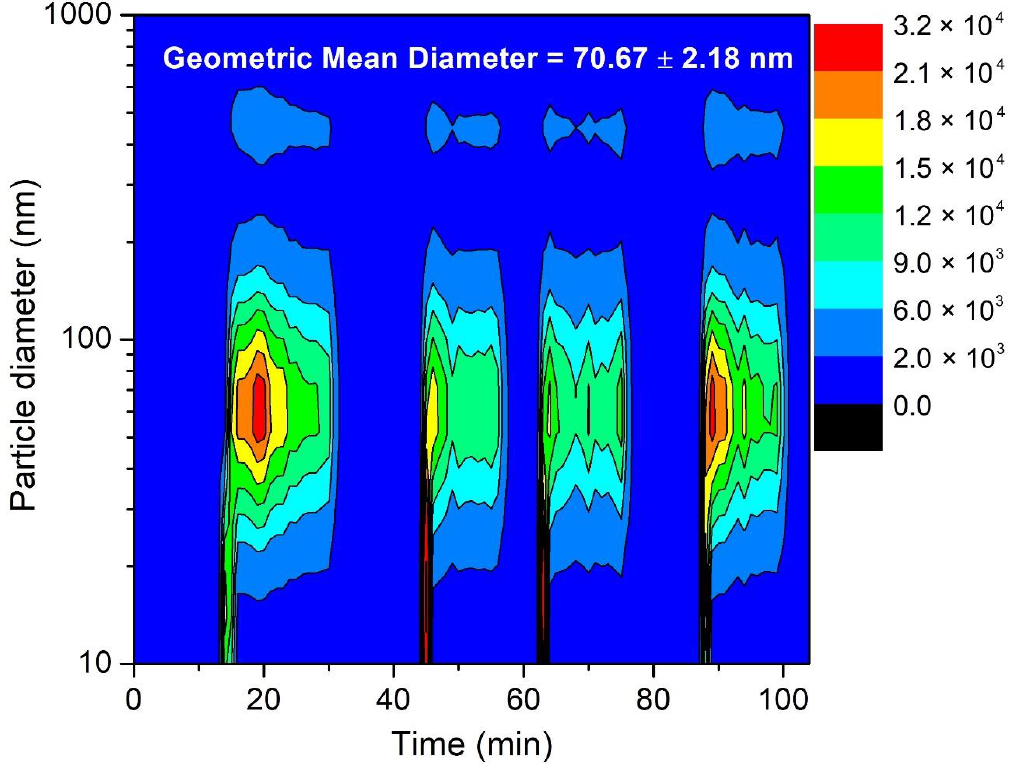
Figure 7. The 3D contour plot of particle generation from the four repetitions. Colour bar indicates the normalized concentration of dN/dlogDp. the normalized concentration of